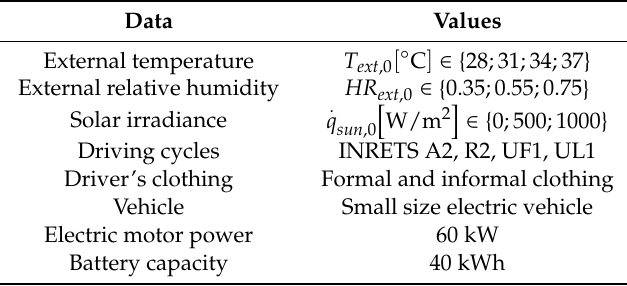
Table 2. Summary of simulation